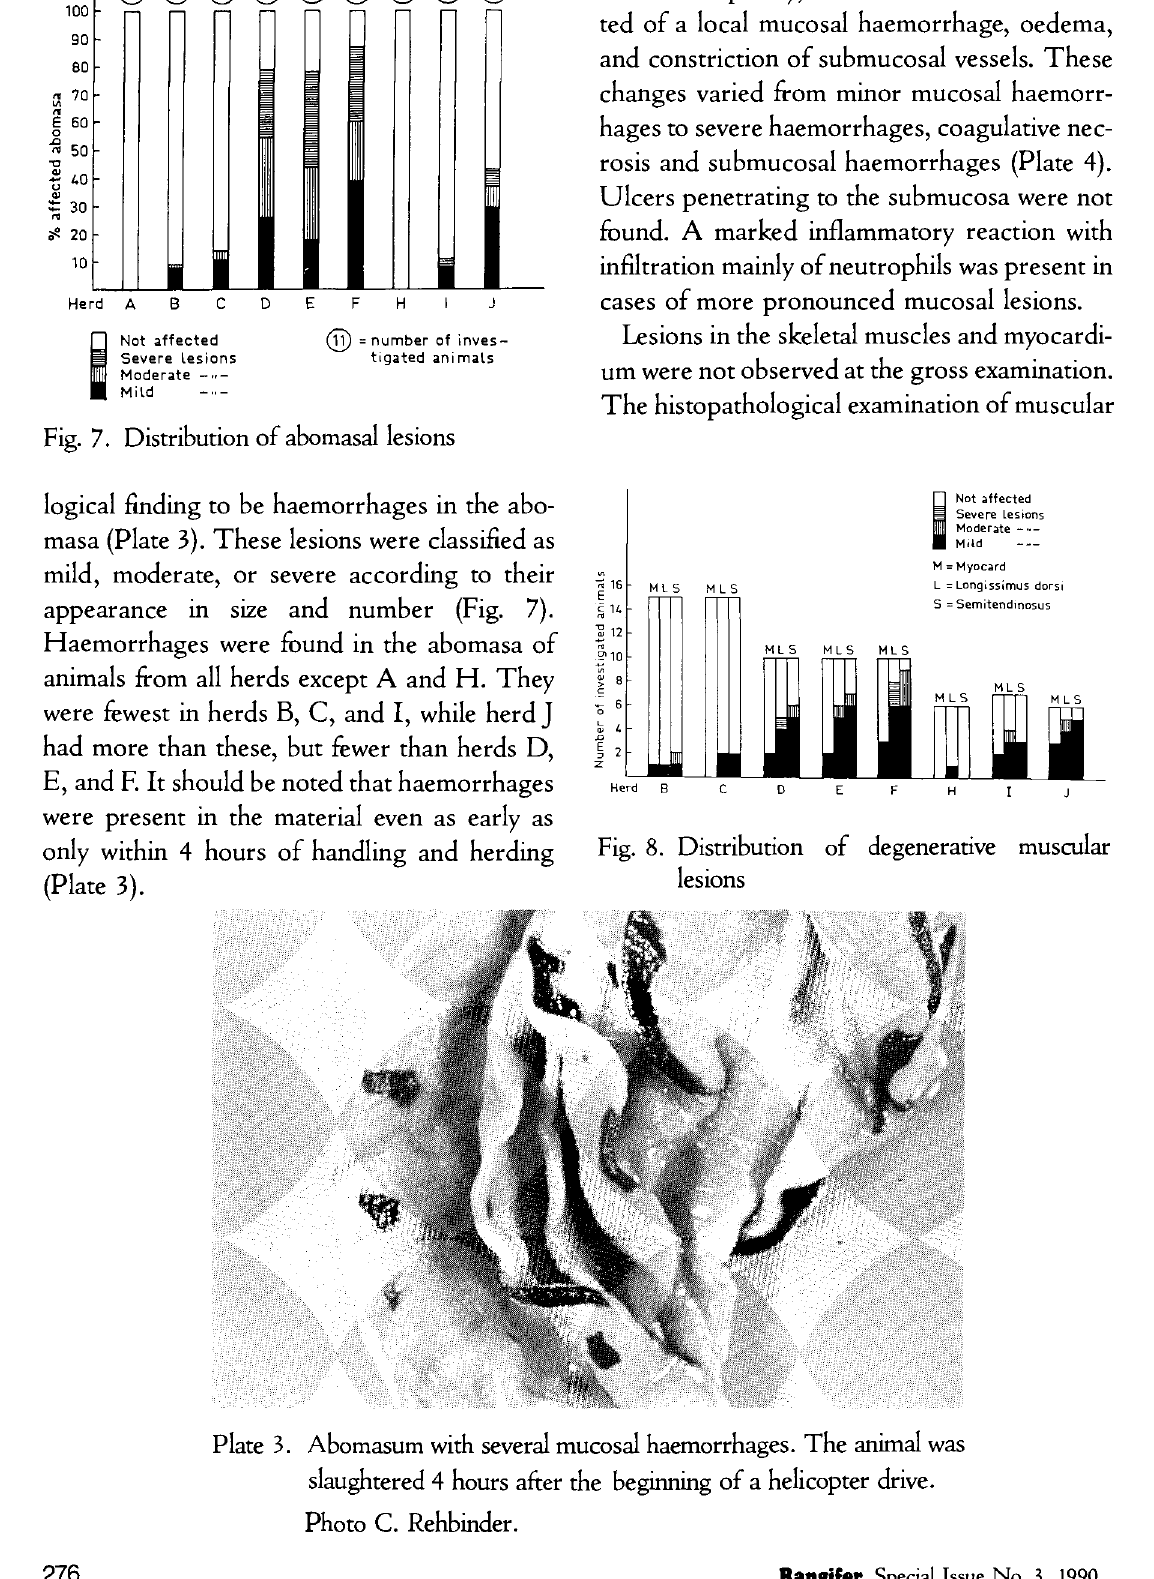
Fig. 7. Distribution of abomasal lesions